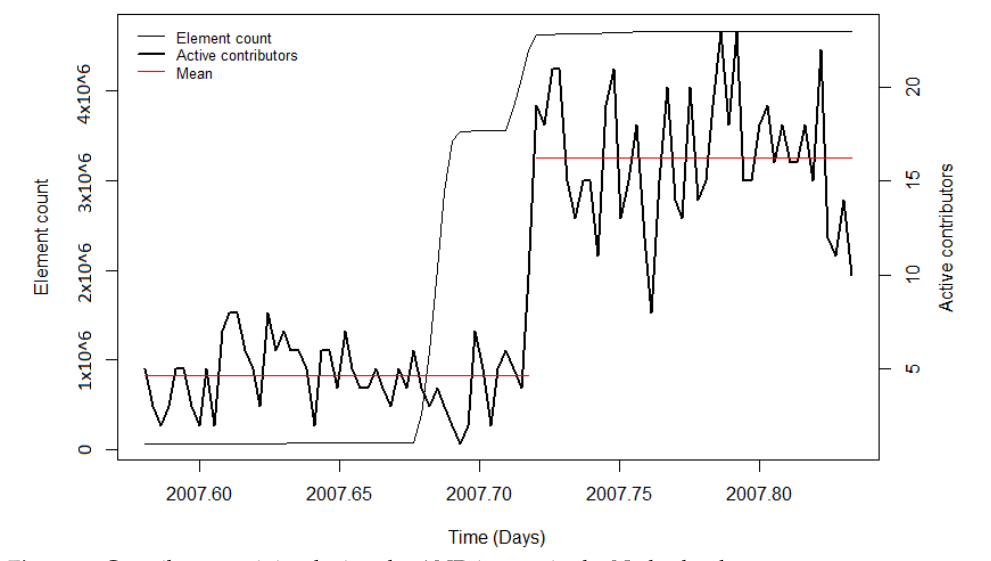
Figure 3. Contributor activity during the AND import in the